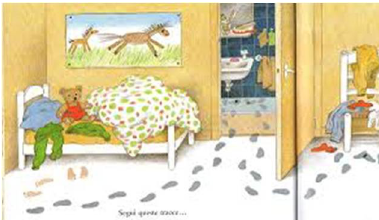
Figure 7. Muller G., Indovina che cosa succede. Una passeggiata invisibile; Babalibri, Italia 2001, [7].